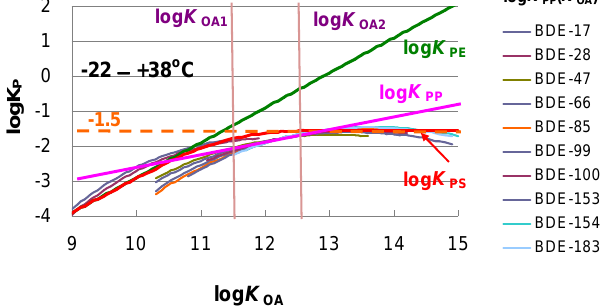
Figure 6. Variation of log K PS (the thick red line, given by Eq. 31), log K PE (the thick dark green line, given by Eq. 3), and log K PP (the thick pink line, given by Eq. 6) as functions of log K OA . The func- tions of log K PP ( K OA ) (the thin lines, given by Eq. 8) vs. log K OA for 10 PBDE congeners in Harbin air at a temperature range of − 22 to + 28 ◦ C are also